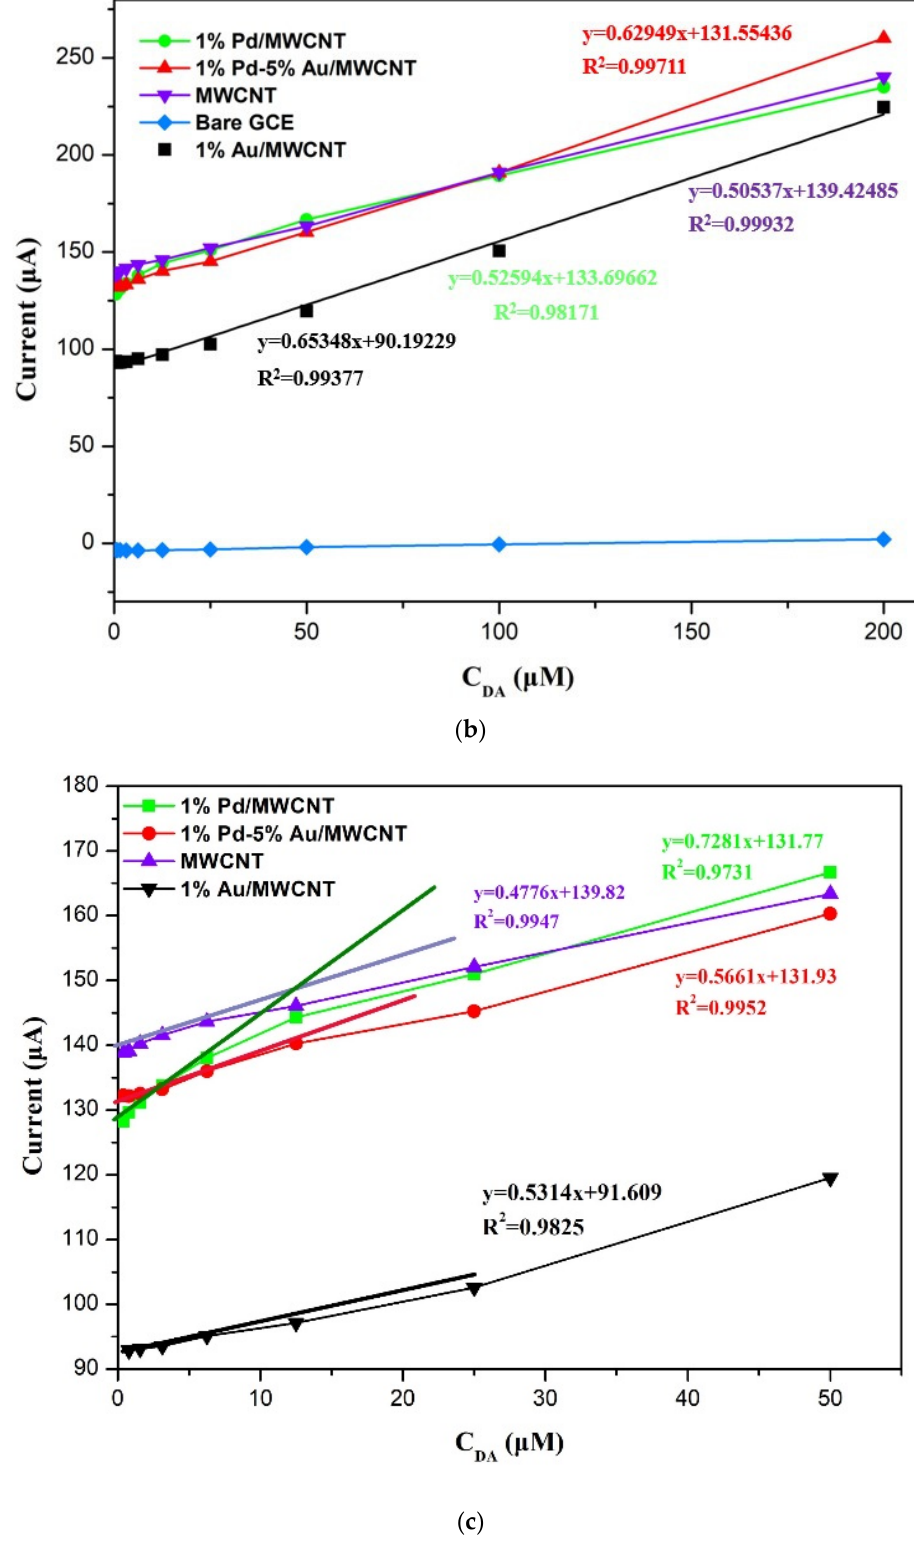
Figure 8. ( a ) DPV curves of different electrodes in 200 μ M dopamine solution. ( b ) The calibration curve between the peak current intensity and dopamine concentration of various kinds of electrodes. ( c ) The DPV current versus DA concentration from 0.098 μ M to 6.8 μ M.